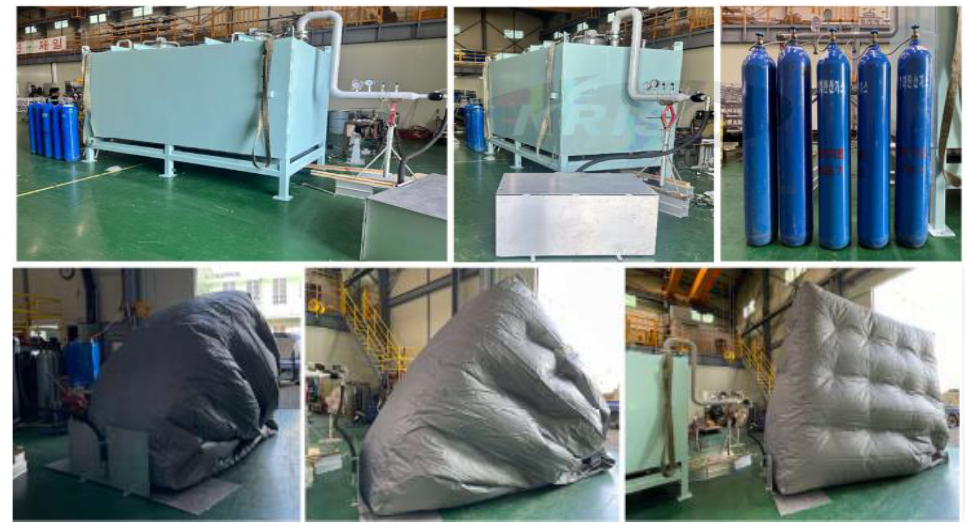
Figure 17. BSS prototype test for installation in a K-GTB machinery room.